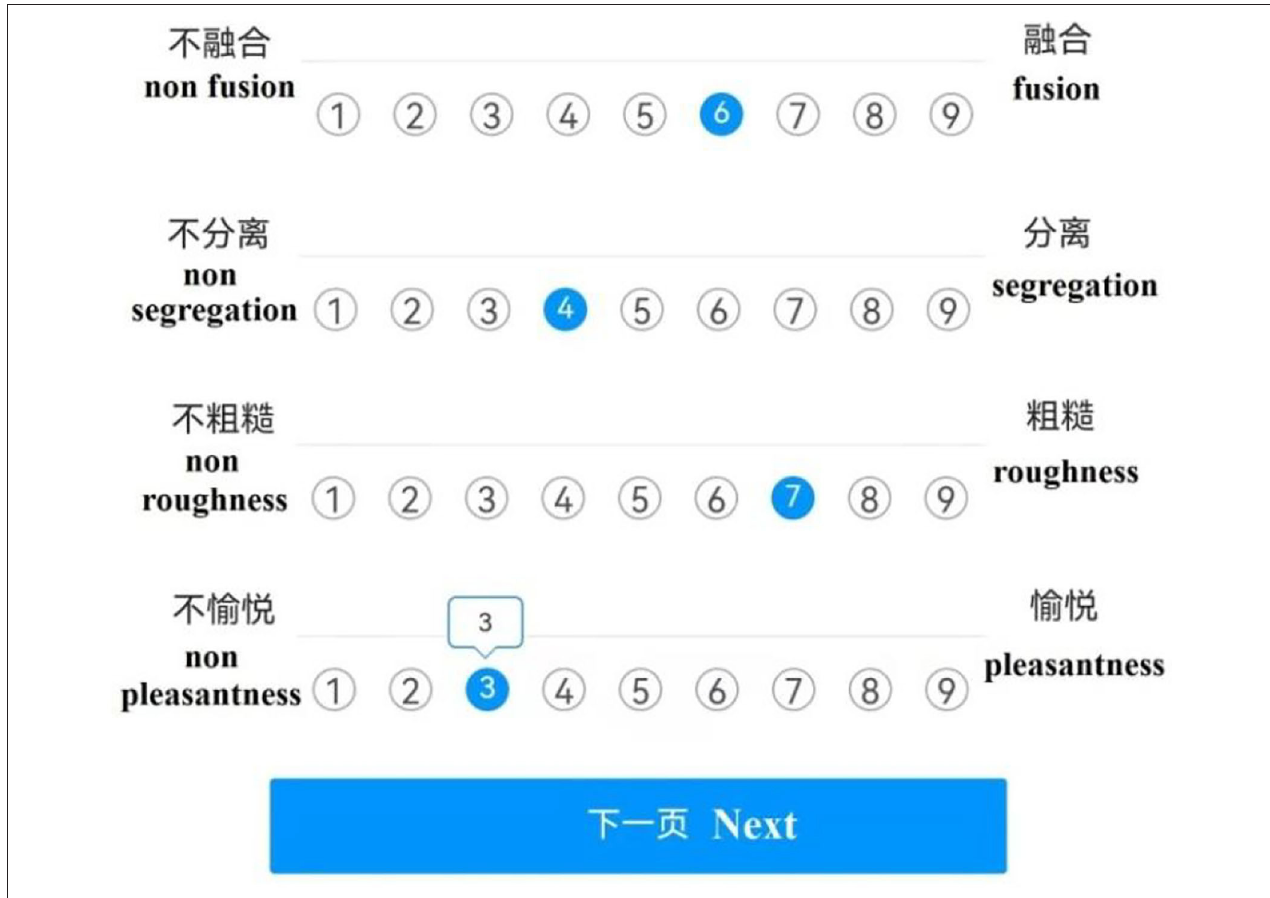
FIGURE 3 | The interface for the listening